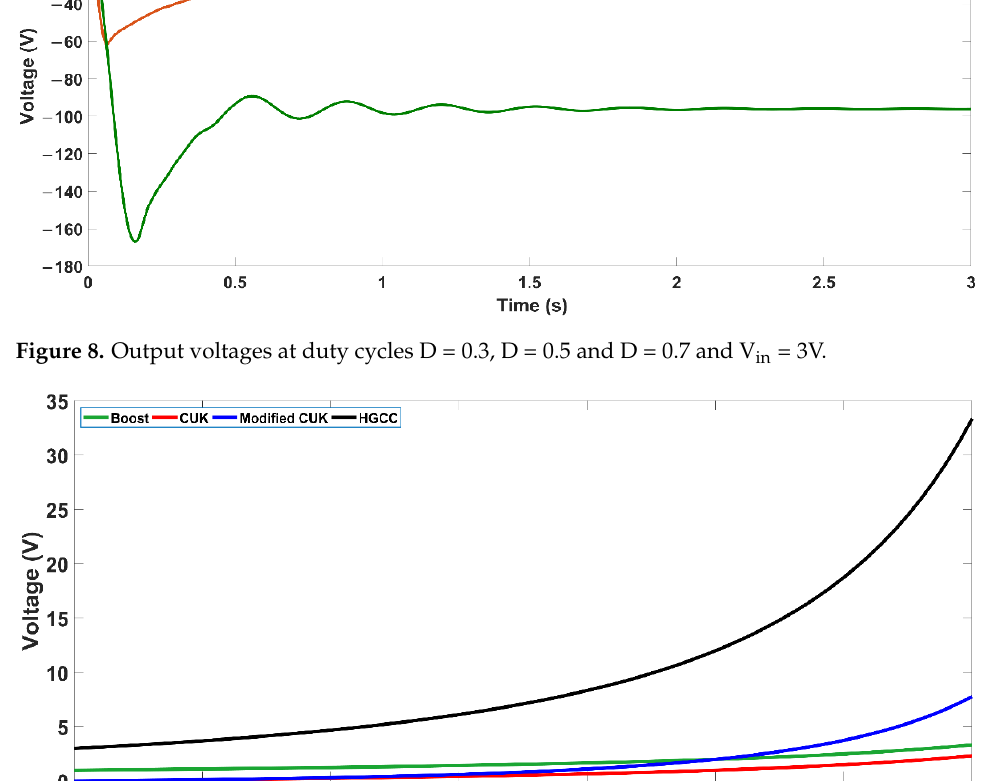
Figure 9. Voltage gains of different topologies at different duty cycles.